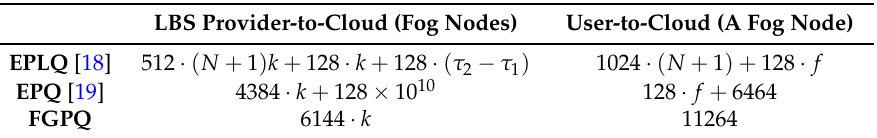
Table 2. Comparison of communication overhead